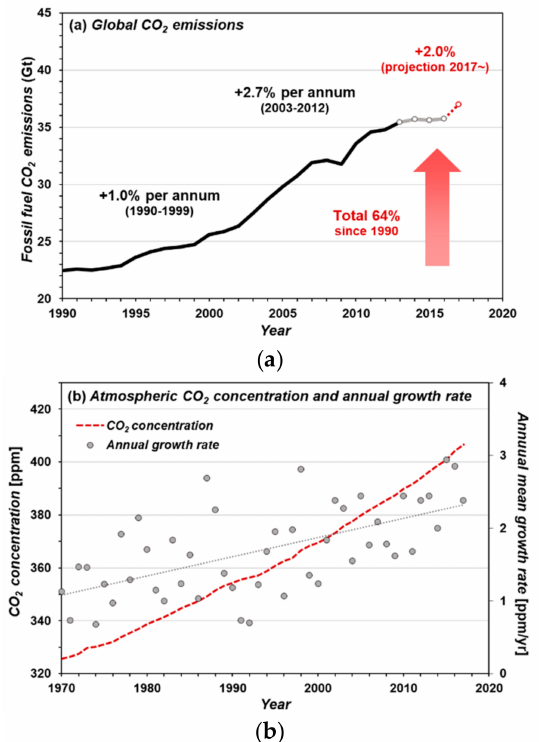
Figure 1. Global CO 2 emission status: ( a ) Trend of global CO 2 emissions from fossil fuels. Reproduced with permission from Le Qu é r é et al., Global Carbon Budget 2017 in Earth System Science Data; published by Copernicus Publications, 2018 [5]; ( b ) Atmospheric CO 2 concentration and annual growth. Reproduced with permission from Ed Dlugokencky and Pieter Tans, Trends in atmospheric carbon dioxide (www.esrl.noaa.gov / gmd / ccgg / trends / ); published by the National Oceanic & Atmospheric Administration (NOAA) [4].